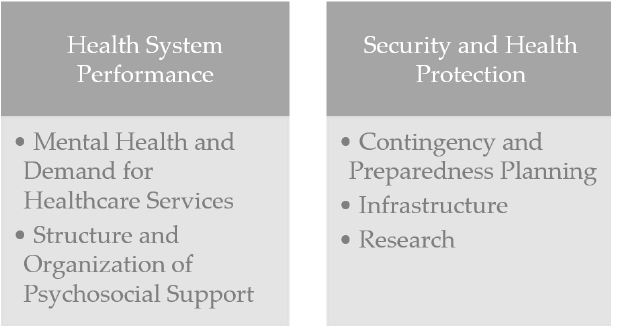
Figure 1. Overview of the aggregated long-term impacts of the analyzed disasters on the public health system (source: the